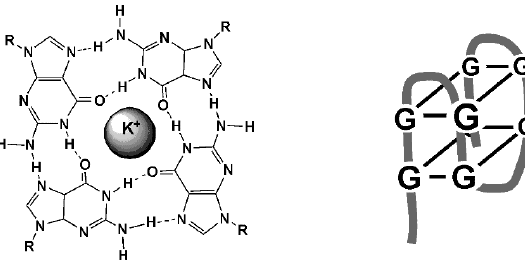
Figure 9. Structure of G 4 quadruplex and folded aptamer.